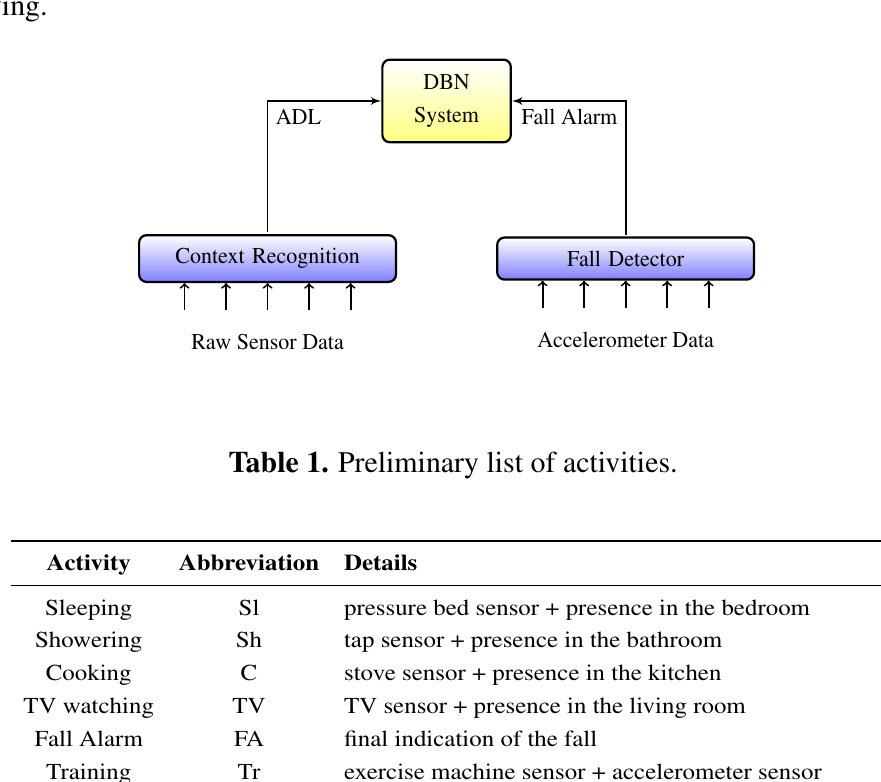
Figure 4. The integrated system. DBN, dynamic Bayesian network; ADL, activities of daily living.